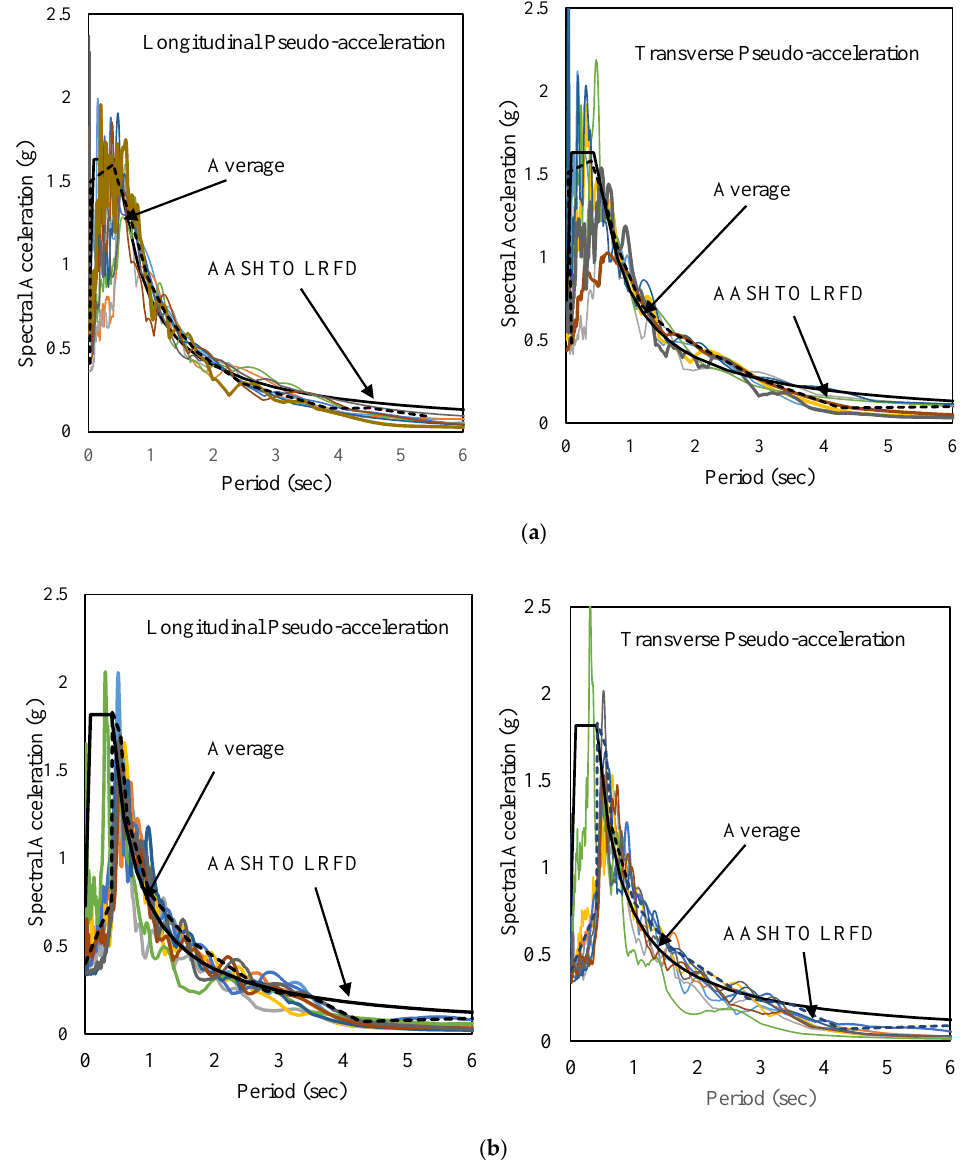
Figure 10. Response spectra of the scaled ground motion records. ( a ) Near-field ground motion; ( b ) Far-field ground motion.